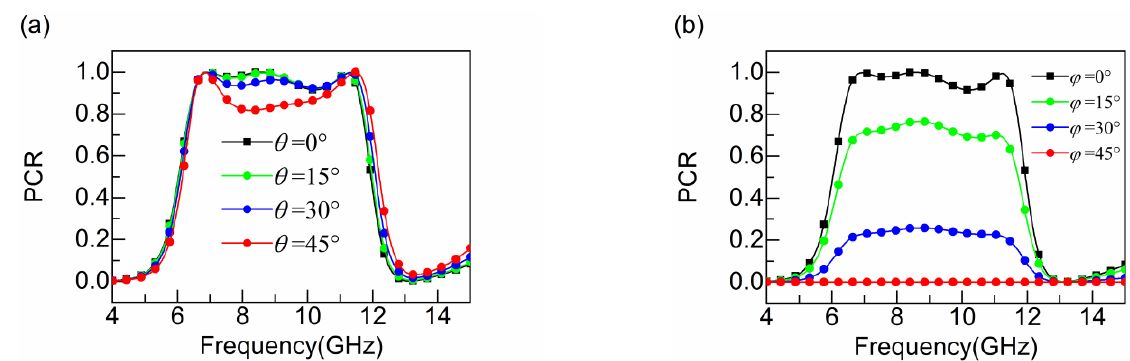
Figure 6. PCR with different parameters ( a ) r 0 ; ( b ) r 1 ; ( c ) w 1 ; ( d ) w 4 .